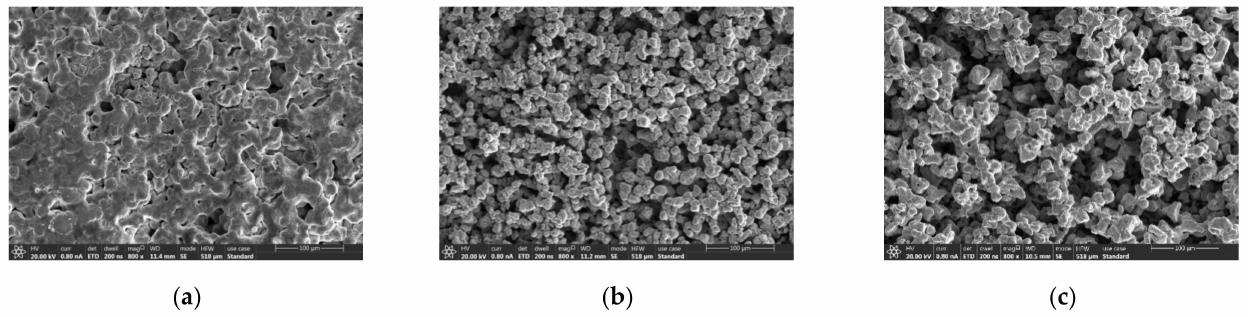
Figure 13. SEM of cathode products at ( a ) 700 ◦ C, ( b ) 750 ◦ C and ( c ) 800 ◦ C ( E = 1.8 V, t = 8